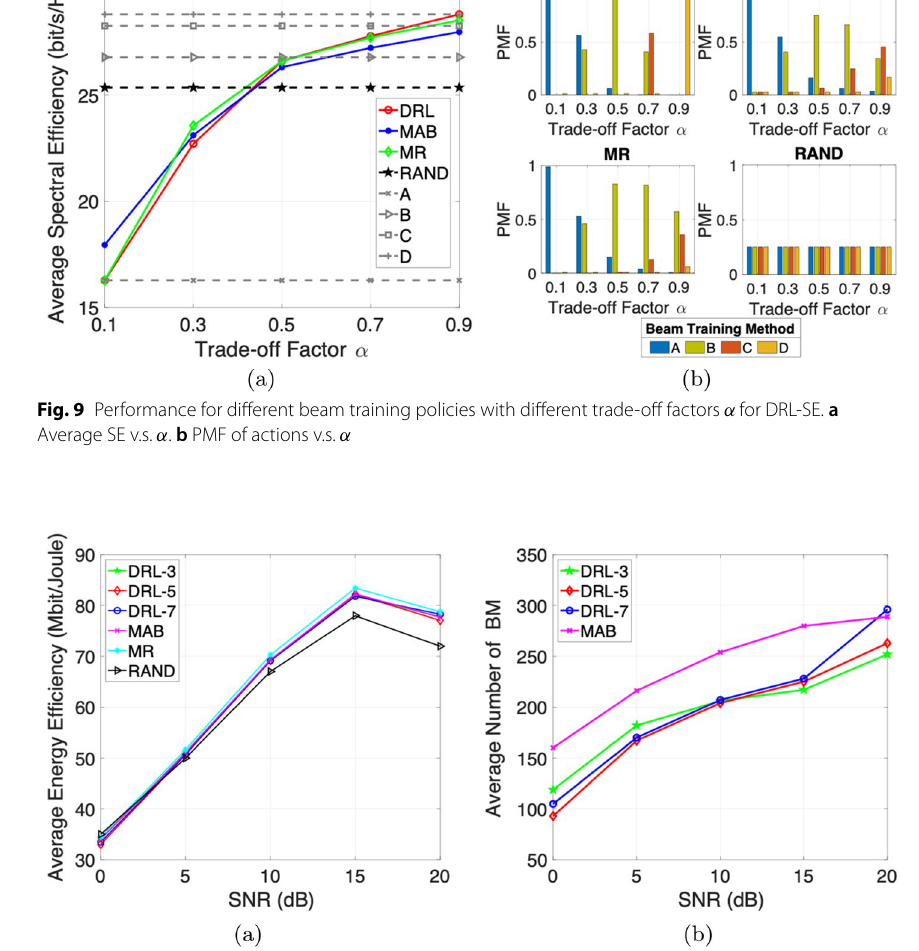
Fig. 10 Performance for different beam training policies at multiple SNRs for DRL-EE. a Average EE v.s. SNR. b Average number of BM v.s.